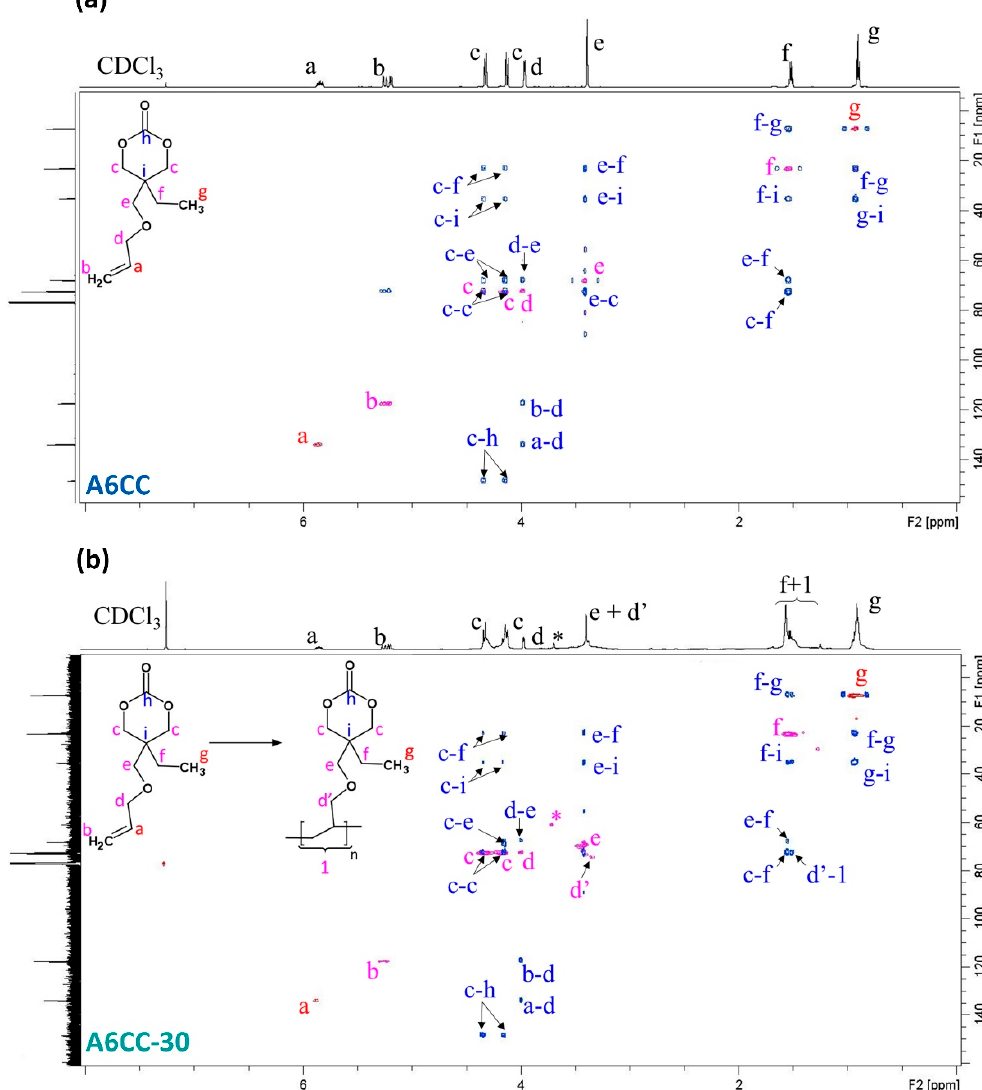
Figure 5. HSQC-HMBC cross-peaks of the ( a ) A6CC and ( b ) A6CC-30 samples, where red (odd) and pink (even) contours represent HSQC, and blue contours correspond to HMBC. HSQC reveals carbon–proton interaction, while HMBC shows the interaction between the proton and neighboring carbons. (*) corresponds to the methylene groups of the detected by-product.